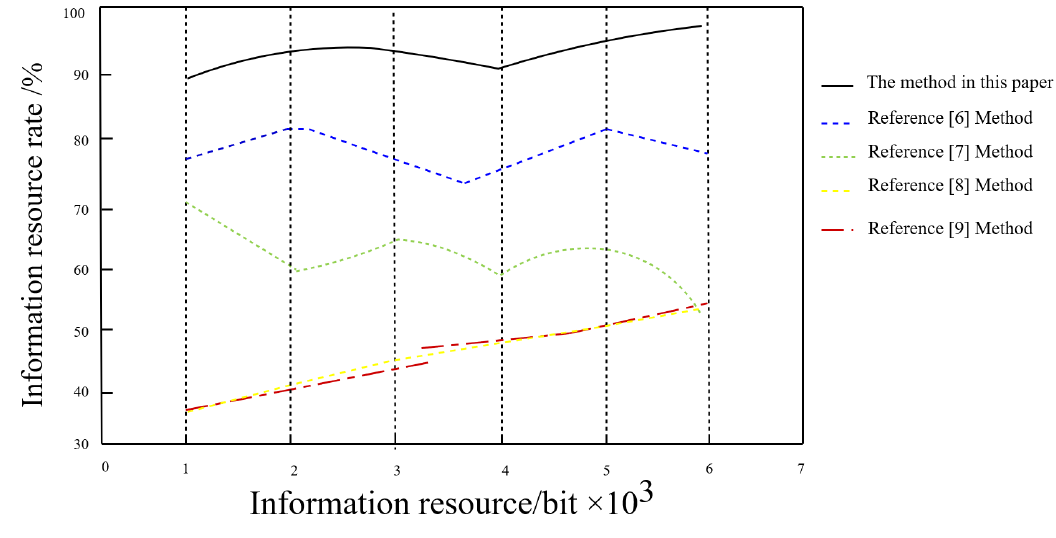
Figure 4. Recognition rate of information